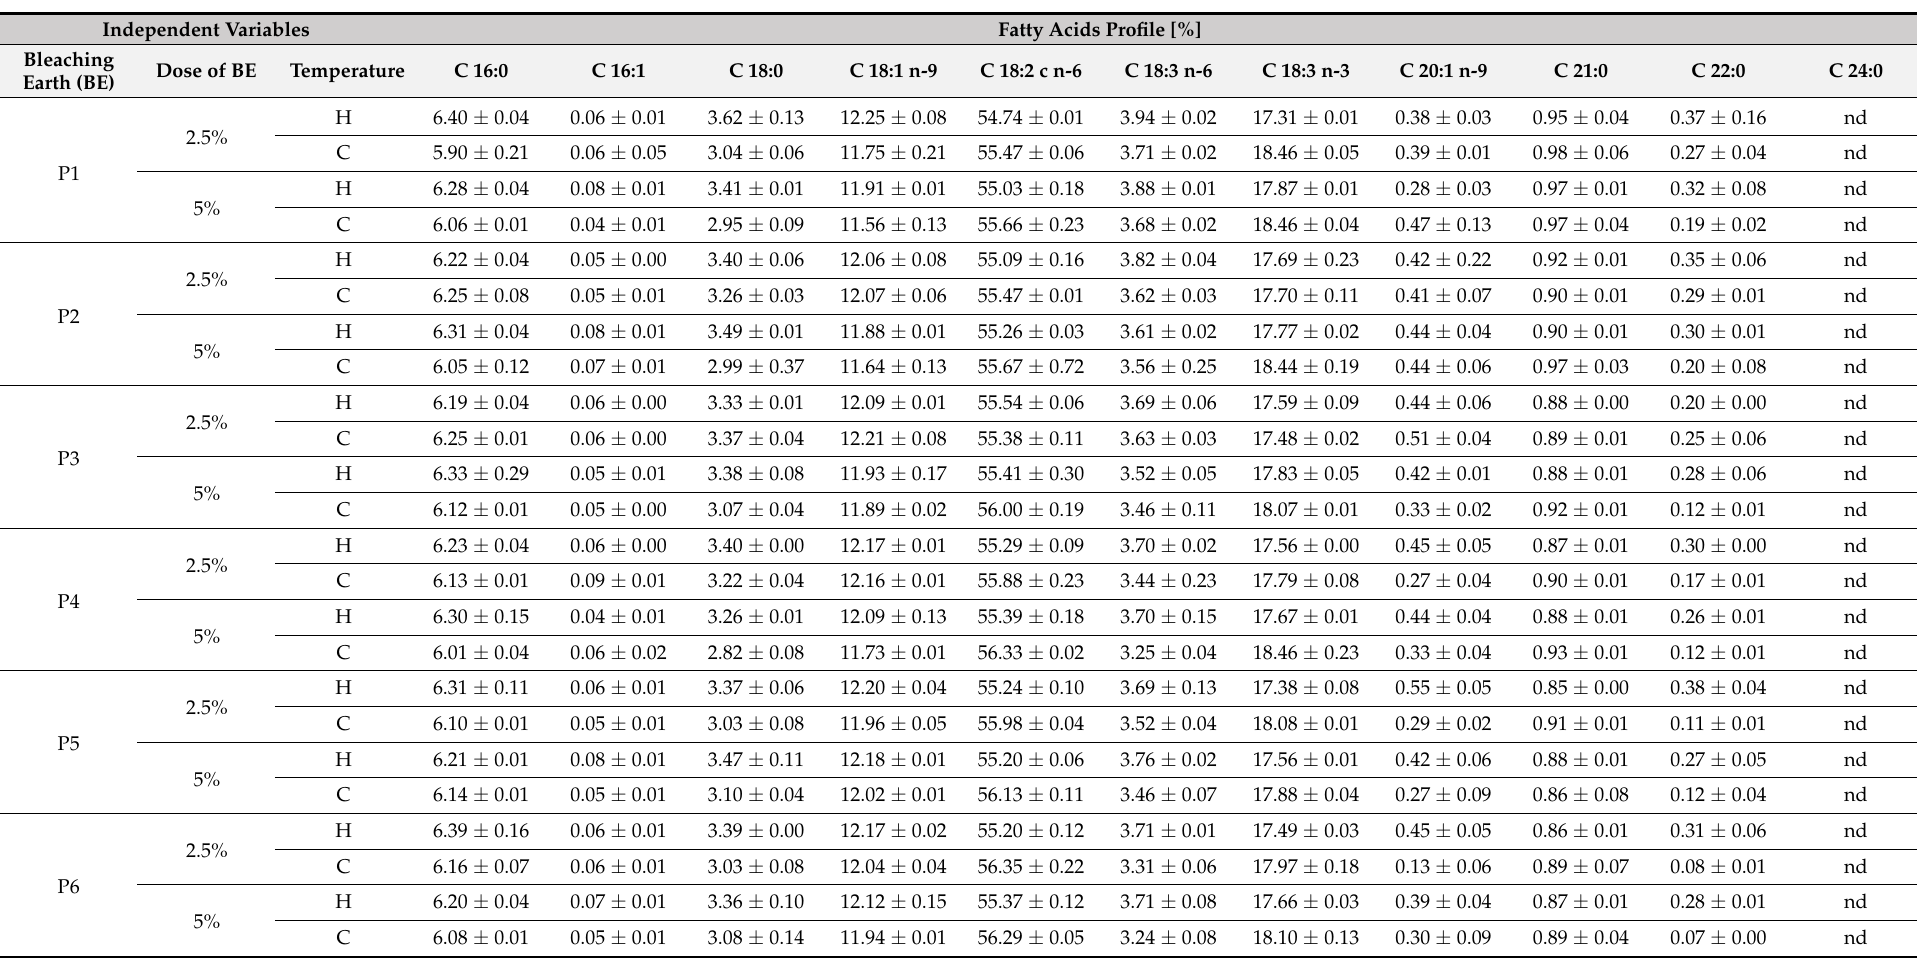
Table A1. Fatty acids profile of bleaching hemp oil from the ‘S. Jubileu’